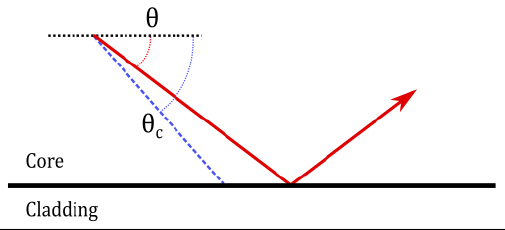
Figure 8. Polar angle and maximum polar angle θ c as measured from the fiber propagation